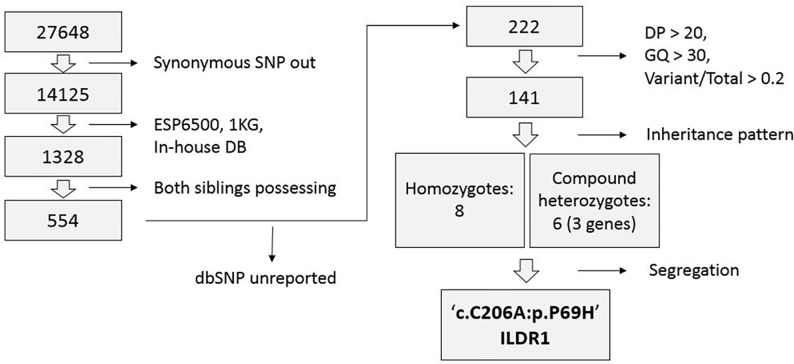
Filtering and prioritization steps for novel variant identification.Of the 27,648 variants identified in two siblings, all synonymous SNPs were excluded, and only rare variants (< 1%) based on NIHBL-ESP6500, the 1000 Genomes Project and our in-house database (44 Koreans) were included for subsequent analysis. Only variants that have not been reported in dbSNP137 were selected. Low-quality read depth (DP) and genotype (GP) under 20 and 30, respectively, or variant/total depth less than 0.2 were also discarded. Under the recessive model, eight variants of homozygotes and six variants of compound heterozygotes (11 genes in total) were identified. Further filtering of these variants was performed by Sanger sequencing and by confirming co-segregation with the phenotype. The remaining variants were also cross-checked against dbSNP138 to further exclude the irrelevant variants to the phenotype.